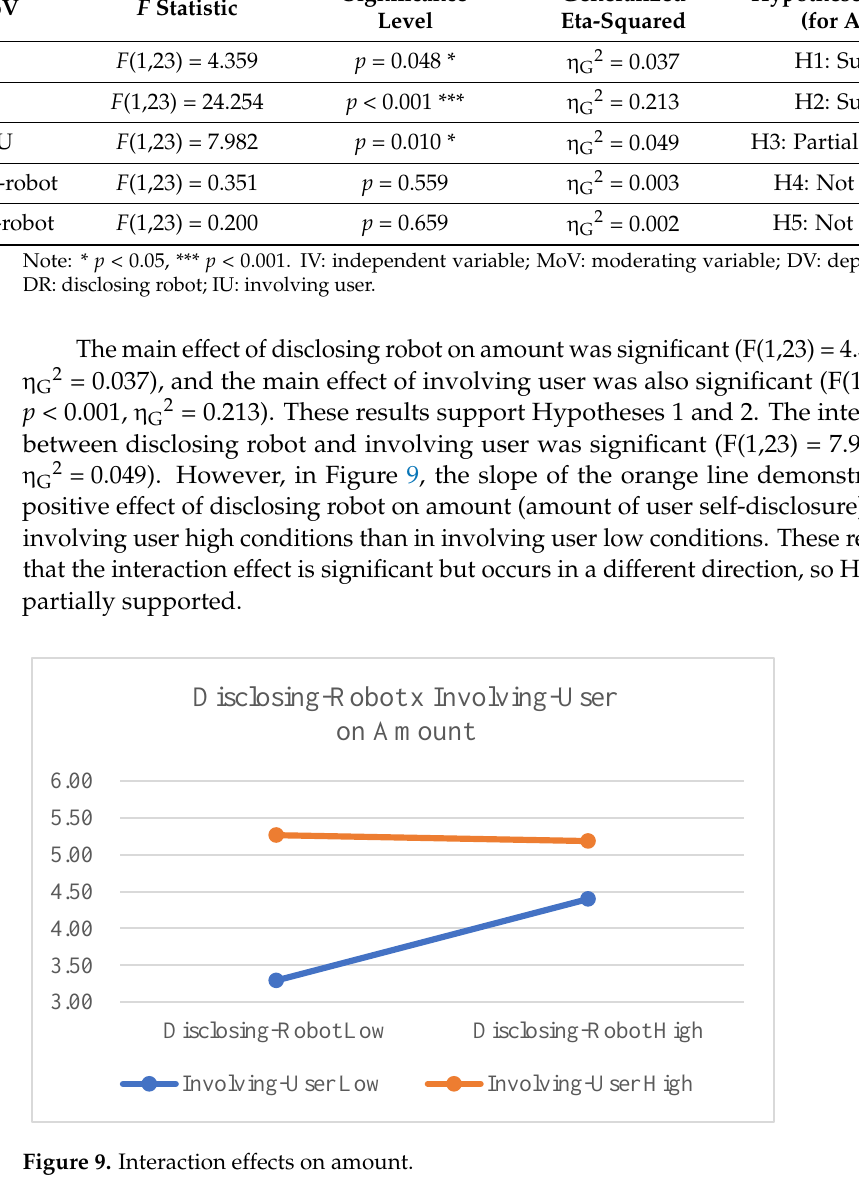
Figure 10. Moderation effects of multi-robot on amount. 4.3.4. Summary of Hypothesis Testing Hypotheses 1 and 2 were fully supported because of the significant ANOVA results in all sub-dimensions of the dependent variable (DV). Hypothesis 3 was partially sup- ported, which is consistent with our expectation for speech length, but the direction of the interaction effect was different from its direction in other sub-dimensions. Hypothe- sis 4 was partially supported because the sub-dimension of DV showed significant re- sults for depth. Hypothesis 5 was partially supported because the speech length of DV’s sub-dimension was significant. Table 7 summarizes the results.